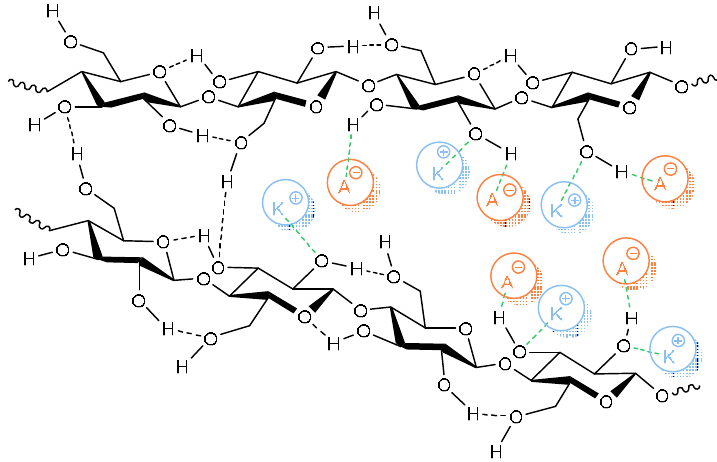
Figure 10. The mechanism of cellulose dissolution in ionic liquid.